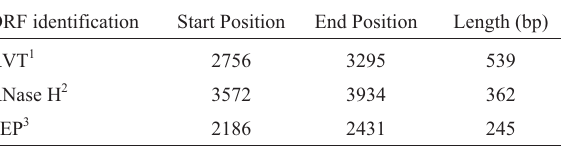
Table 1 - EgEVE_1 domains and related gene